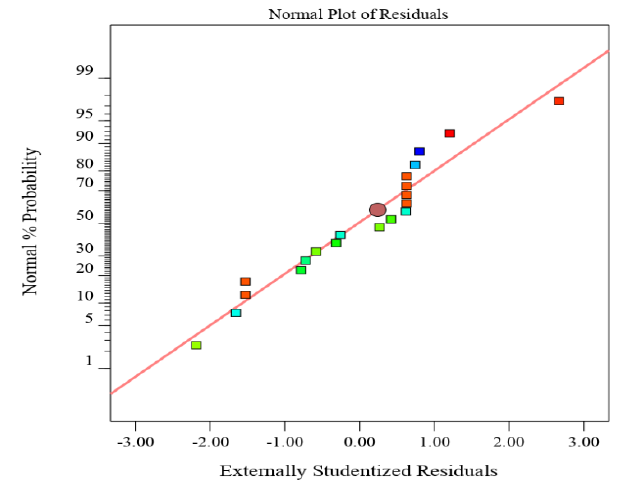
Figure 3. Normal probability plot of the residuals of a quadratic polynomial model for Lactobacillus plantarum